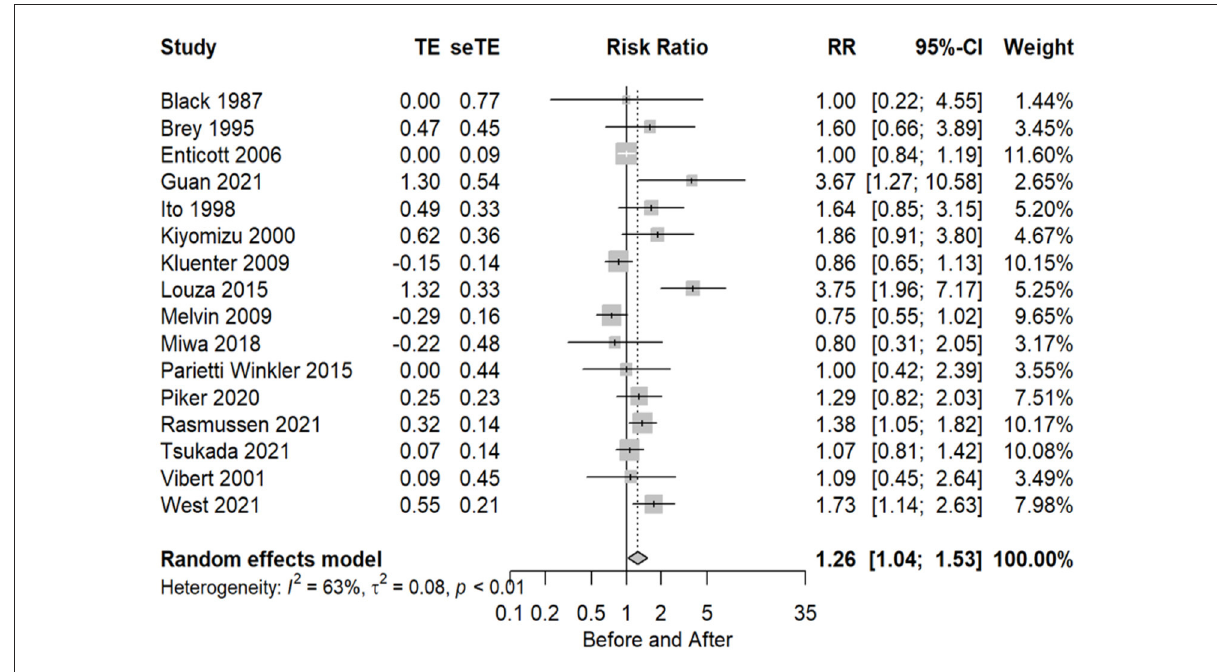
FIGURE3 Forest plot (showing relative effect sizes) for the caloric